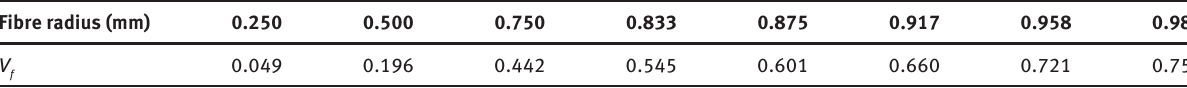
) used in CFD simulation. f